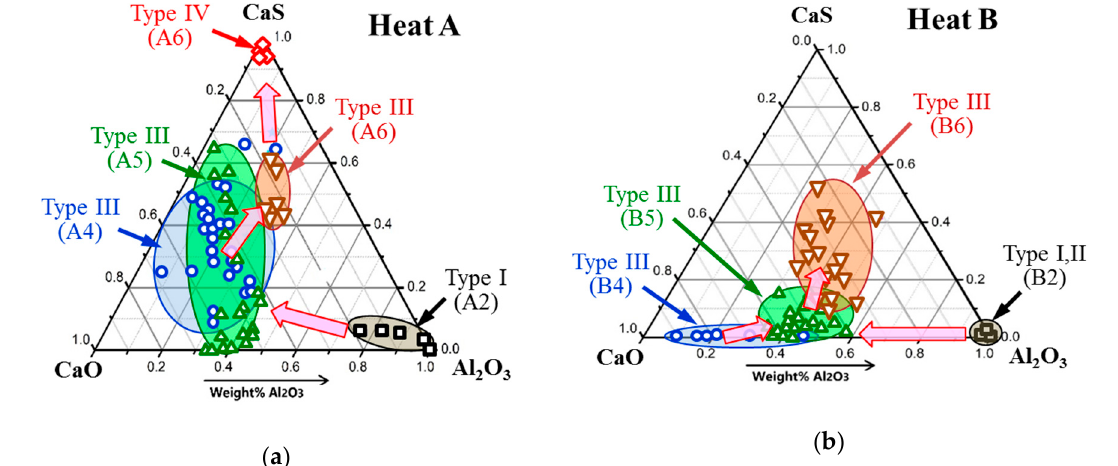
Figure 7. Modification of typical oxide and oxy-sulfide inclusions in steel samples: ( a ) Heat A; ( b ) Heat B.